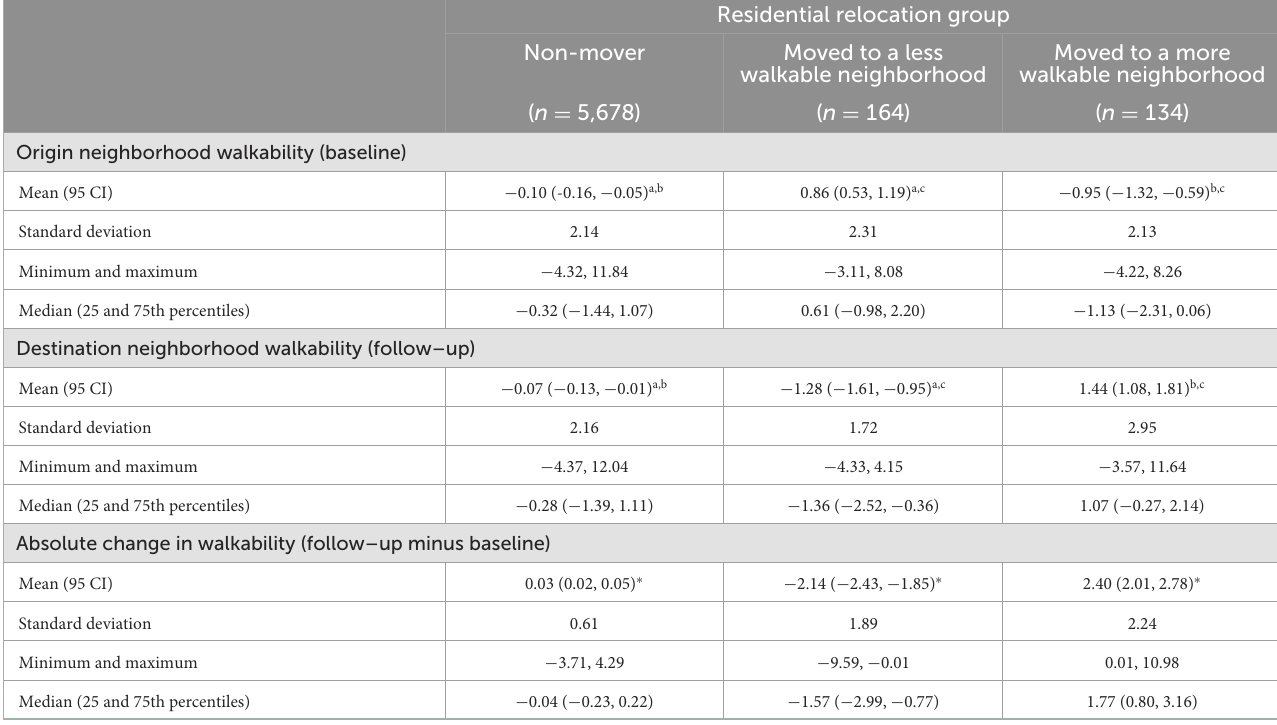
TABLE 2 Walkability scores for origin and destination neighborhoods by residential relocation